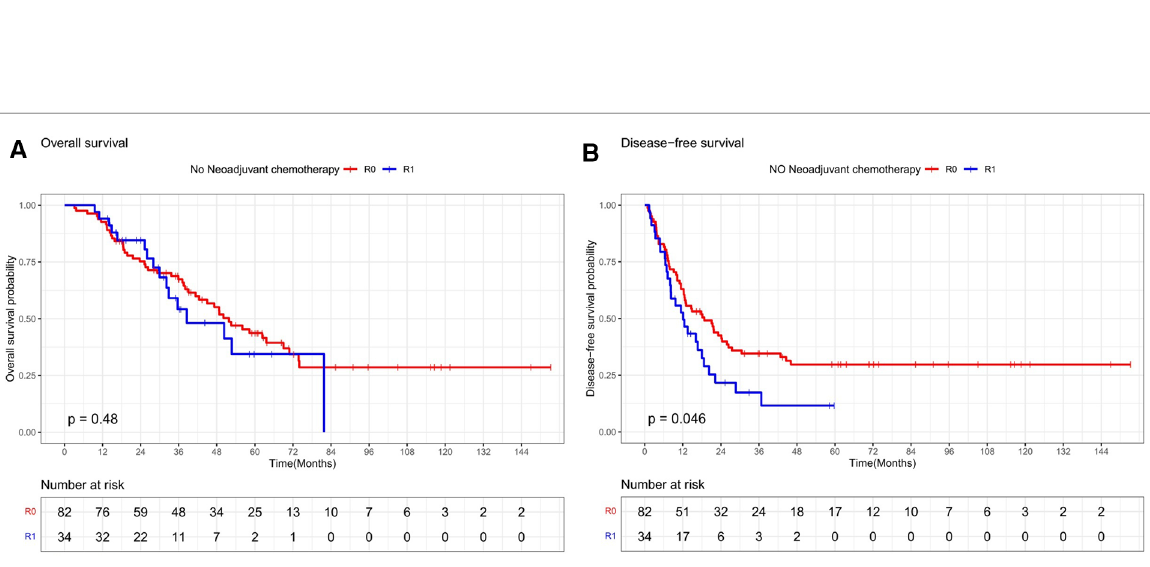
FIGURE 3 Os and DFS survival curves for R0 and R1 in patients not receiving neoadjuvant chemotherapy.